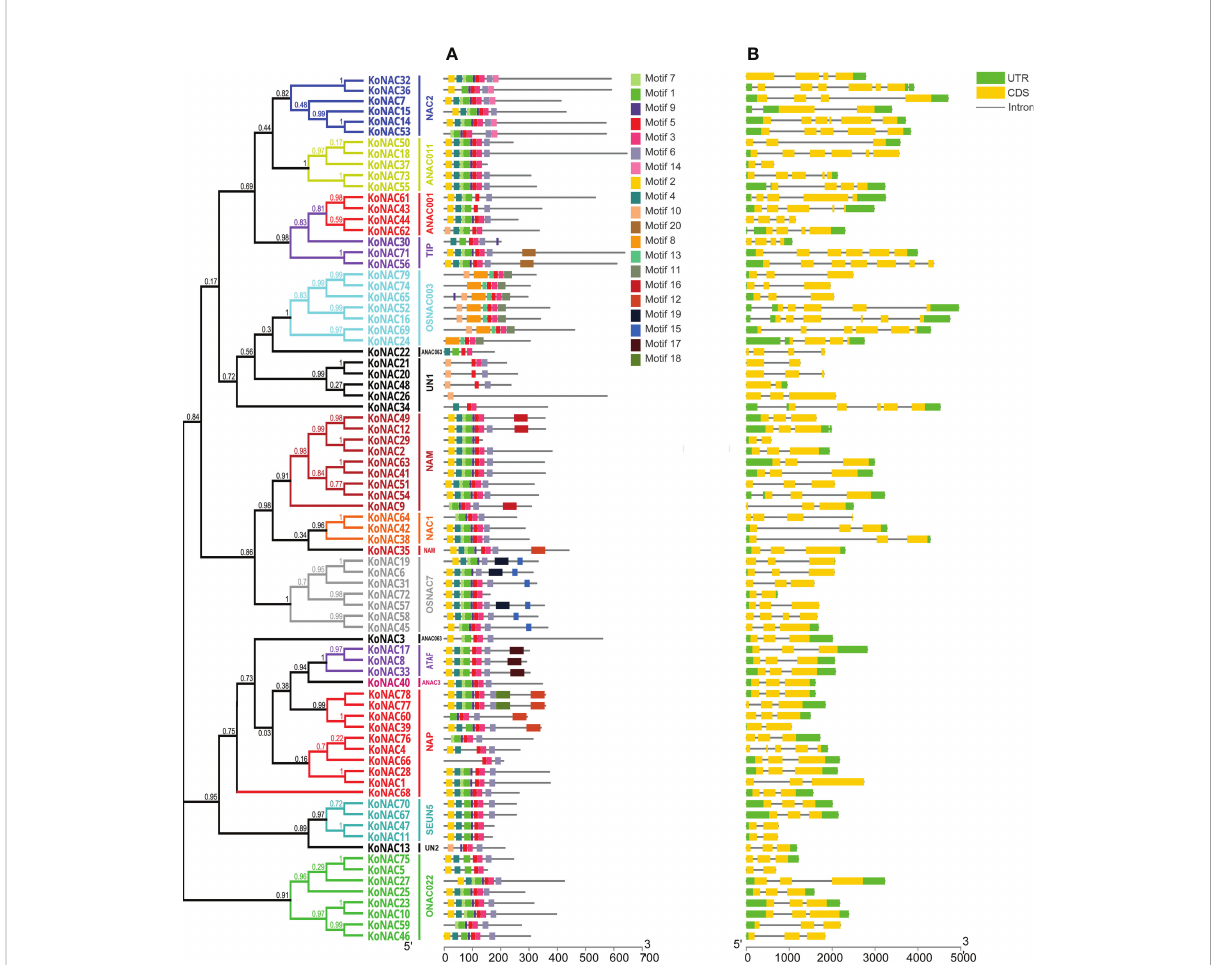
FIGURE 2 Conserved motifs of KoNACs and gene structures of KoNACs according to their phylogenetic relationships. The gene structures of KoNACs (A) were predicted with GSDS software. A green box represents the untranslated region (UTR), a yellow box represents an exon, and a black line represents an intron. The conserved motifs (B) were identi fi ed by the MEME web server. Each motif is indicated by a colored box, and the location of each motif can be estimated using the scale at the